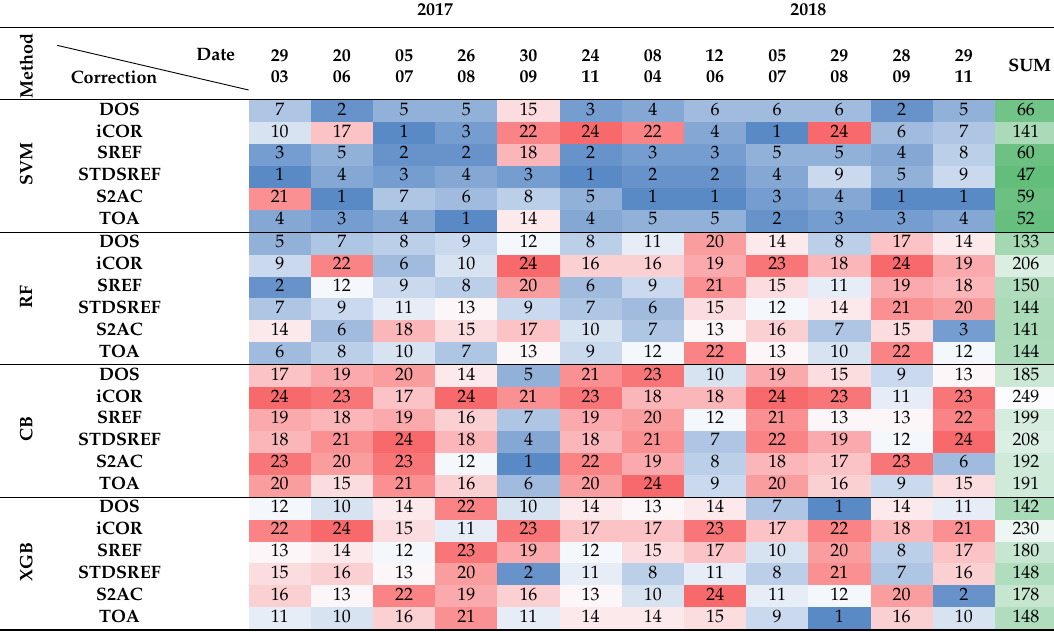
Table 4. Ranking of method and correction by date without radiometric indices. Ranking is provided by place